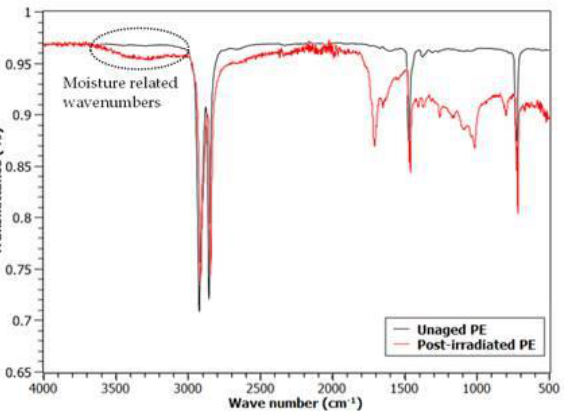
Figure 8. Example of ATR FTIR spectrum of a post-irradiated sample with reference to the unaged